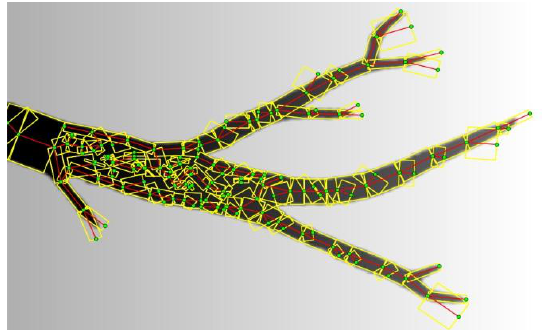
Figure 8. Results achieved by excluding the prior term for graph connectivity ( p s = 0).